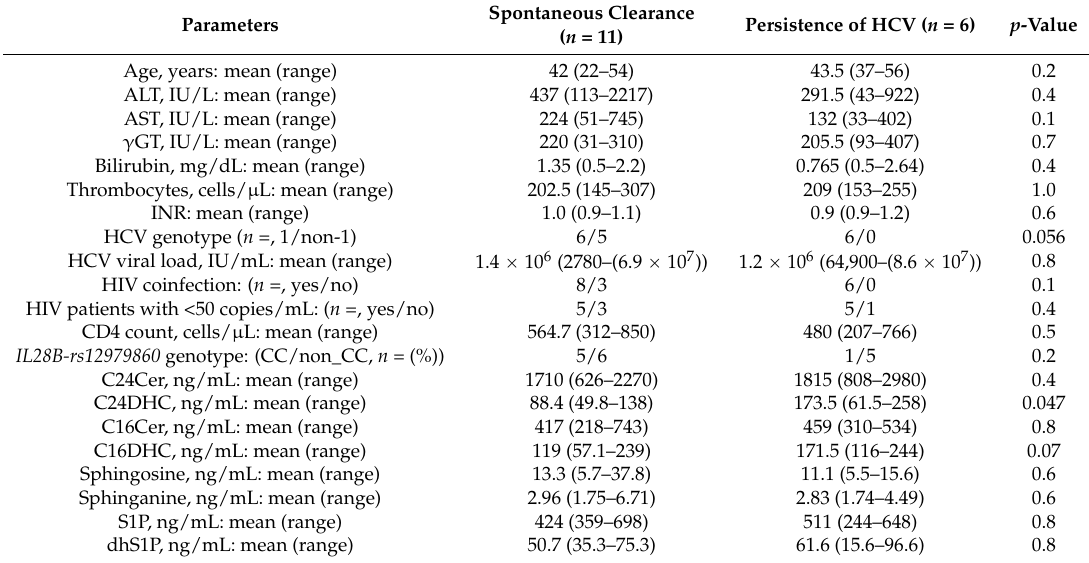
Table 2. Univariate analysis of baseline parameters associated with spontaneous clearance compared to HCV